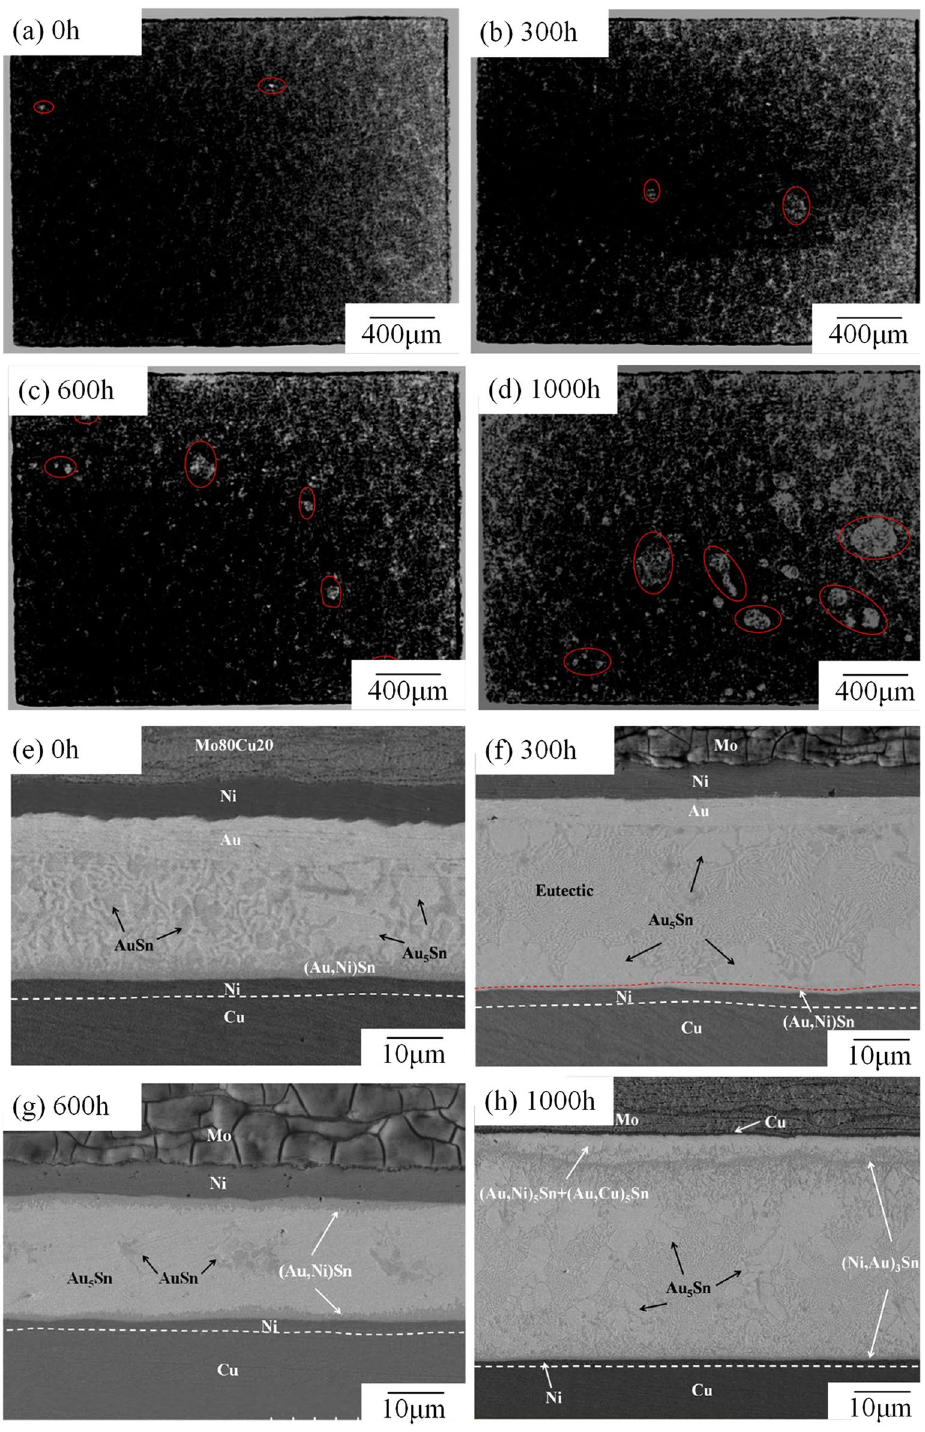
Figure 10 Microstructure of the joints after irradiation [55]: X-ray images of joints with irradiation durations ( a ) 0 h, ( b ) 300 h, ( c ) 600 h, ( d ) 1000 h; SEM micrograph of MoCu20/Cu solder joints ( e ) 0 h, ( f ) 300 h, ( g ) 600 h, ( h ) 1000